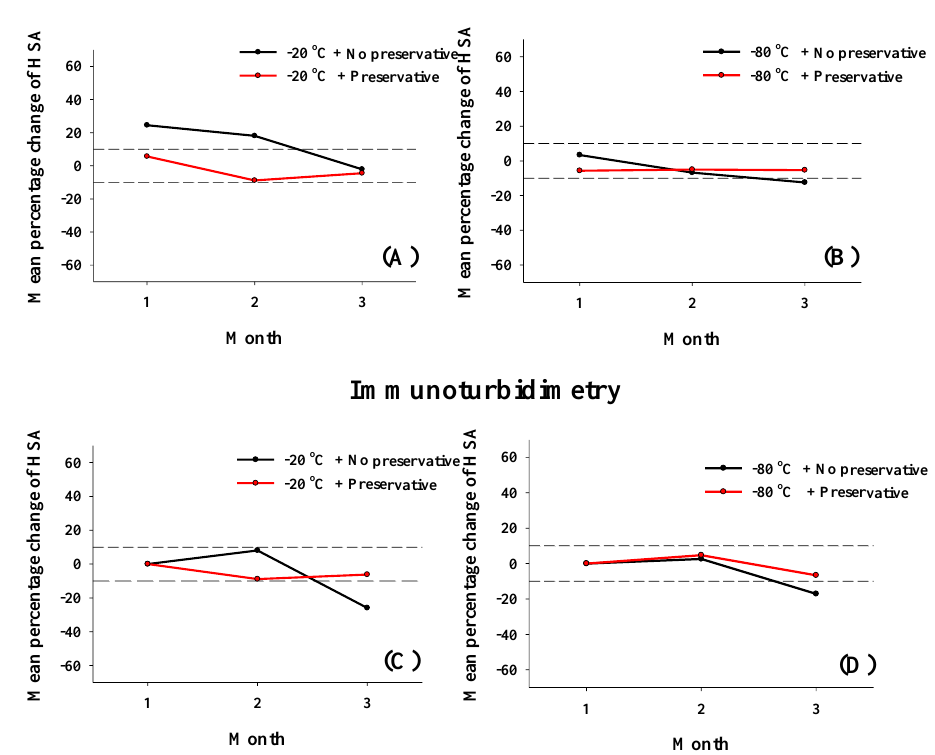
Figure 7. Mean percentage changes in microalbumin concentrations, as determined by GO-based fluorescent detection or by using the aptasensor ( A , B ) and by immunoturbidimetry ( C , D ) assays with and without 2% ( w / v ) boric acid following long-term storage (1, 2 and 3 months). Dashed lines indicate ±10% change from the initial day 0 value.